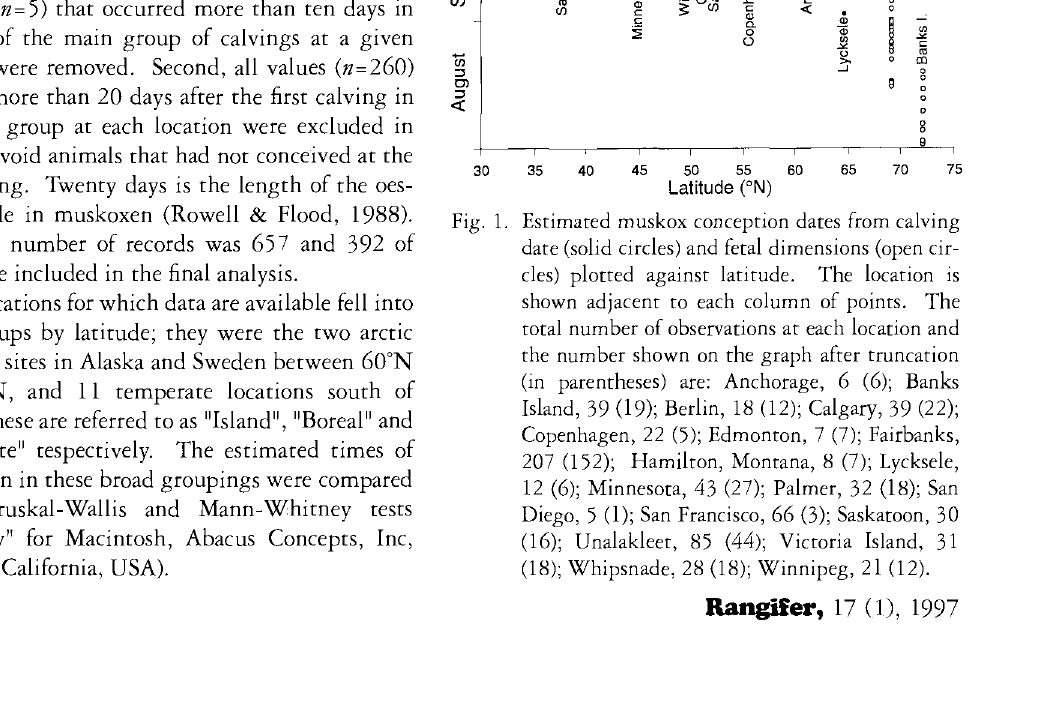
Fig. 1. Estimated muskox conception dates from calving date (solid circles) and fetal dimensions (open cir cles) plotted against latitude. The location is shown adjacent to each column of points.